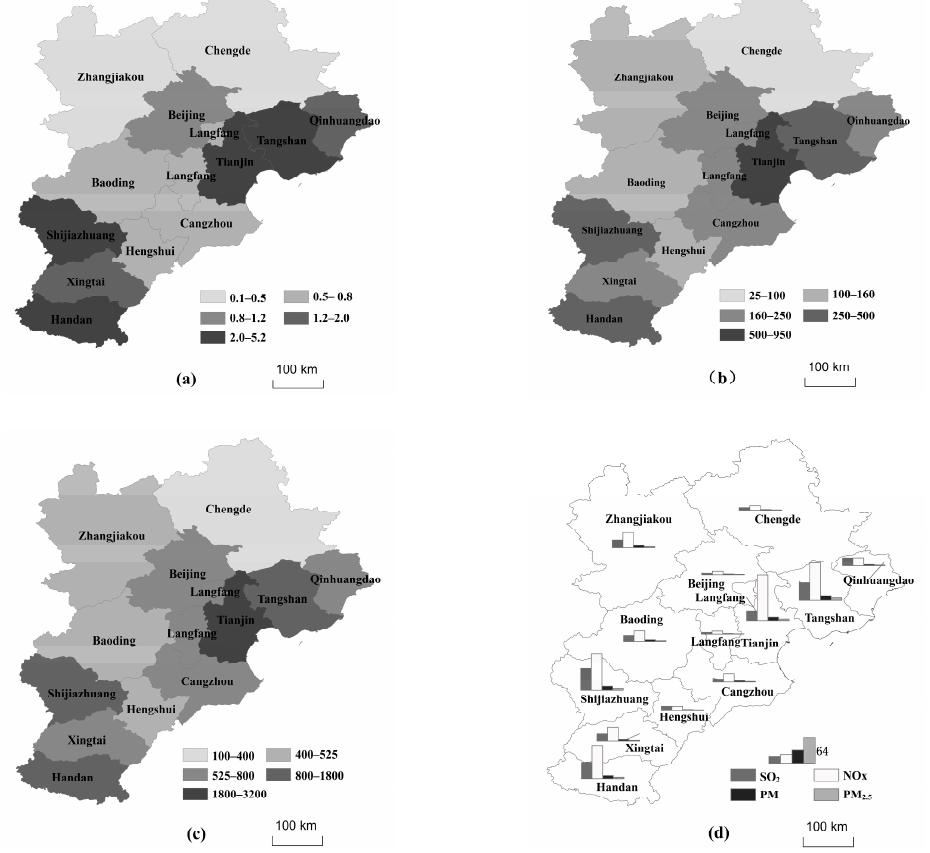
Figure 2. Spatial distribution of thermal power units in the Jing-Jin-Ji Region: ( a ) installations per unit area (10 − 3 units/km 2 ), ( b ) installed capacity per unit area (kW/km 2 ), ( c ) coal consumption per unit area (ton/km 2 /year), ( d ) annual emissions (10 − 3 ton/year).